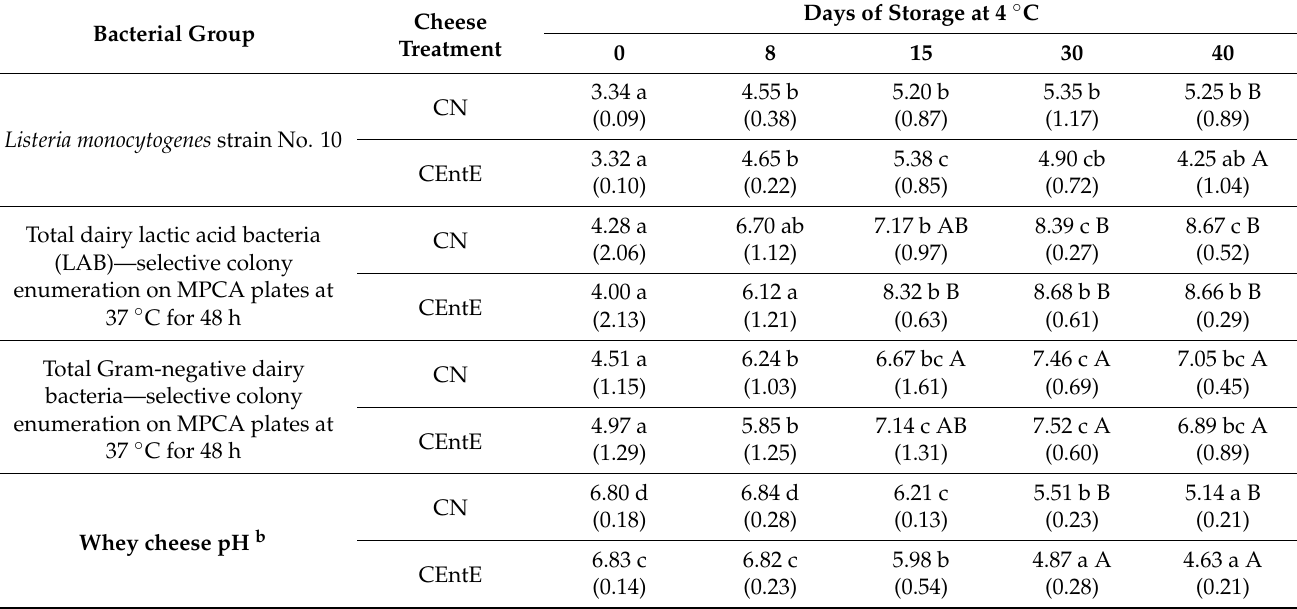
Table 1. Behavior of the inoculated Listeria monocytogenes (log 10 CFU/g) populations in association with the evolution of the primary spoilage bacterial groups and the pH changes during refrigerated (4 ◦ C) storage of fresh, vacuum packaged Anthotyros whey cheeses without (CN) or with (CEntE) addition of 0.5% crude enterocin A-B-P extract a